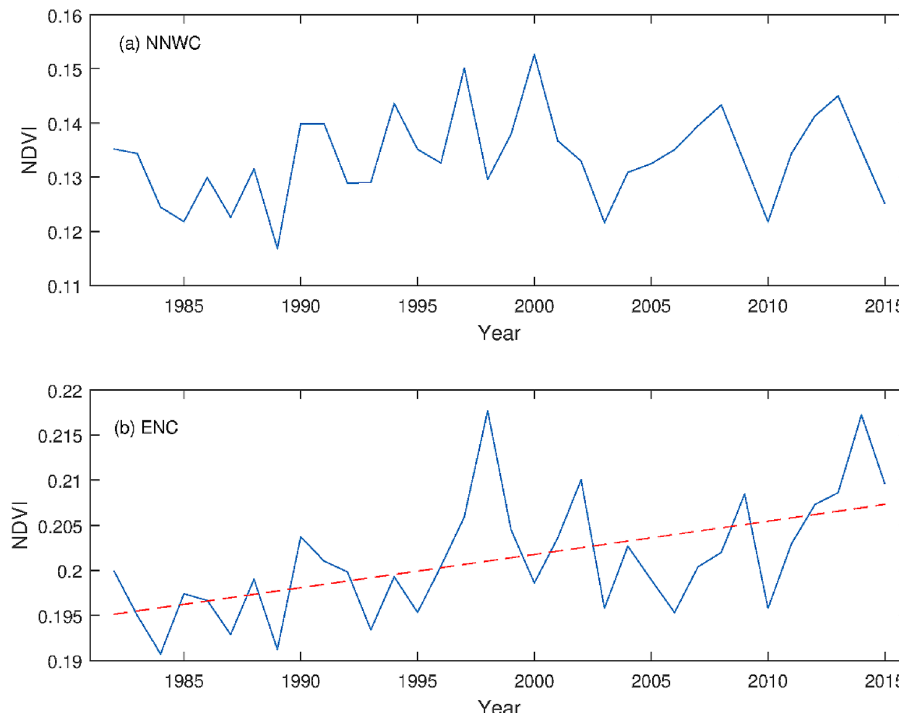
Normalized Deviation of Vegetation Index (NDVI) over northern Northwest China (NNWC) ( a ) and eastern northern China (ENC) ( b ) from 1982 to 2015. The linear trend in NDVI was significant at the 95% confidence level in ( b ) and is indicated by a dashed straight